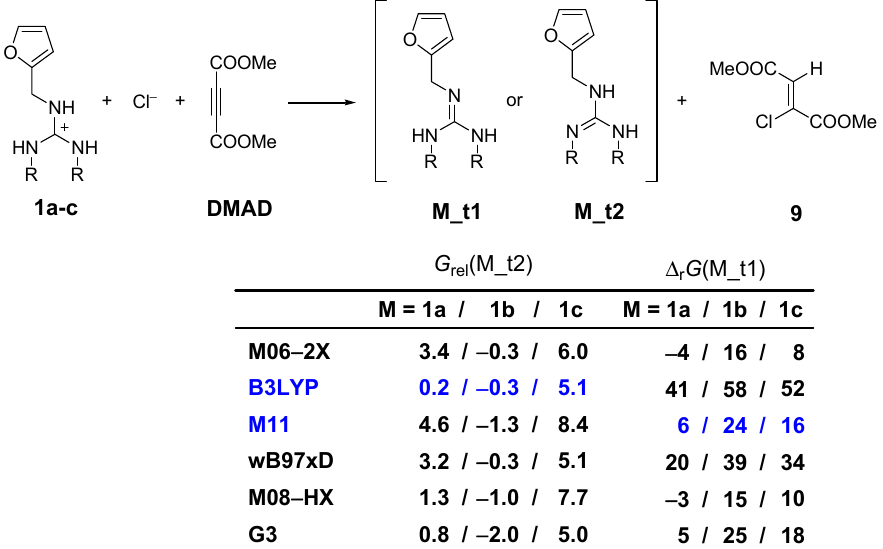
Figure 2. Reaction scheme and energetics for the formation of two possible tautomers by the hydrogen chloride transfer from the guanidinium salt to DMAD . Relative energies of the tautomer M_t2 are given with respect to M_t1 . All energies are given in kJ mol − 1 . The results closest to the G3 values are given in blue